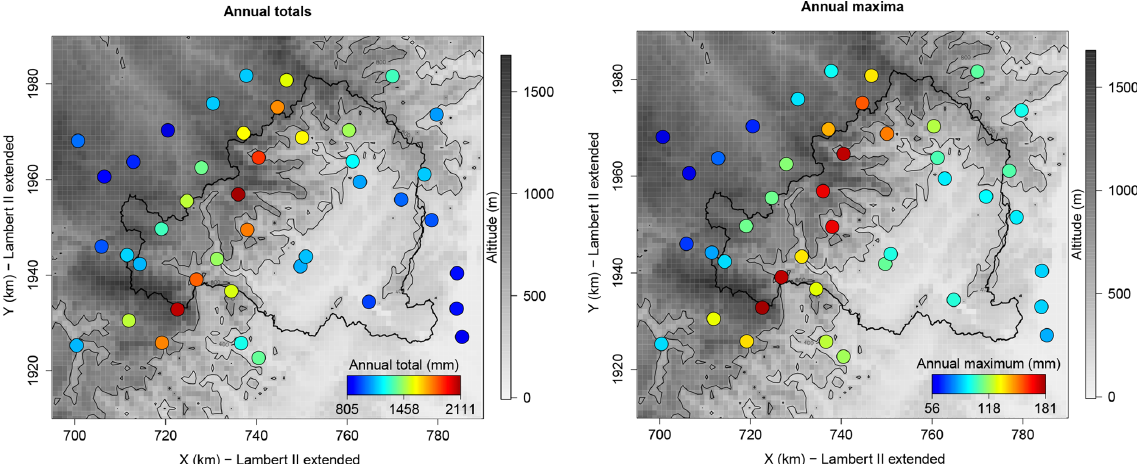
Figure 2. Panel (a) : averages of annual totals (mm). Panel (b) : averages of annual maximum daily rainfalls (mm).